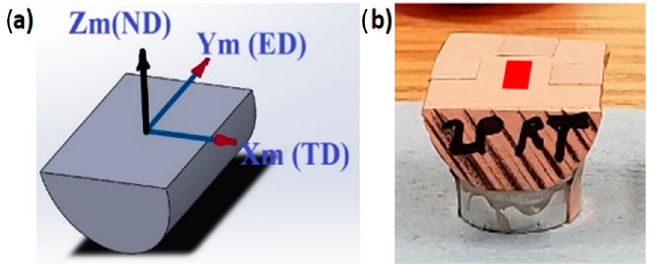
Figure 2. ( a ) Representation of the references axes with respect to the ECAPed sample and ( b ) the position of the EBSD data acquired shown as red square on the longitudinal cross section of the ECAP processed sample.